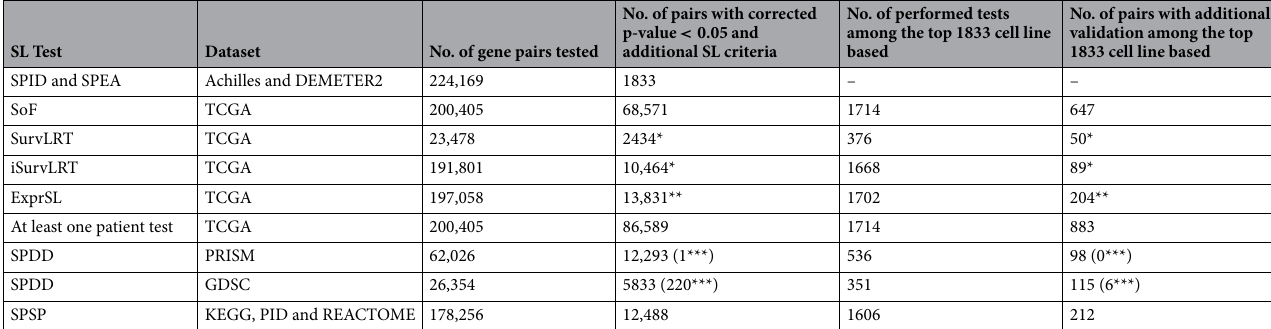
Table 3 (683 focus pairs; referred to as focus ranking) and Supplementary Table 4 (200 focus vs druggable pairs; referred to as focus vs druggable ranking). Combined with plots illustrating all the performed tests (easily avail-